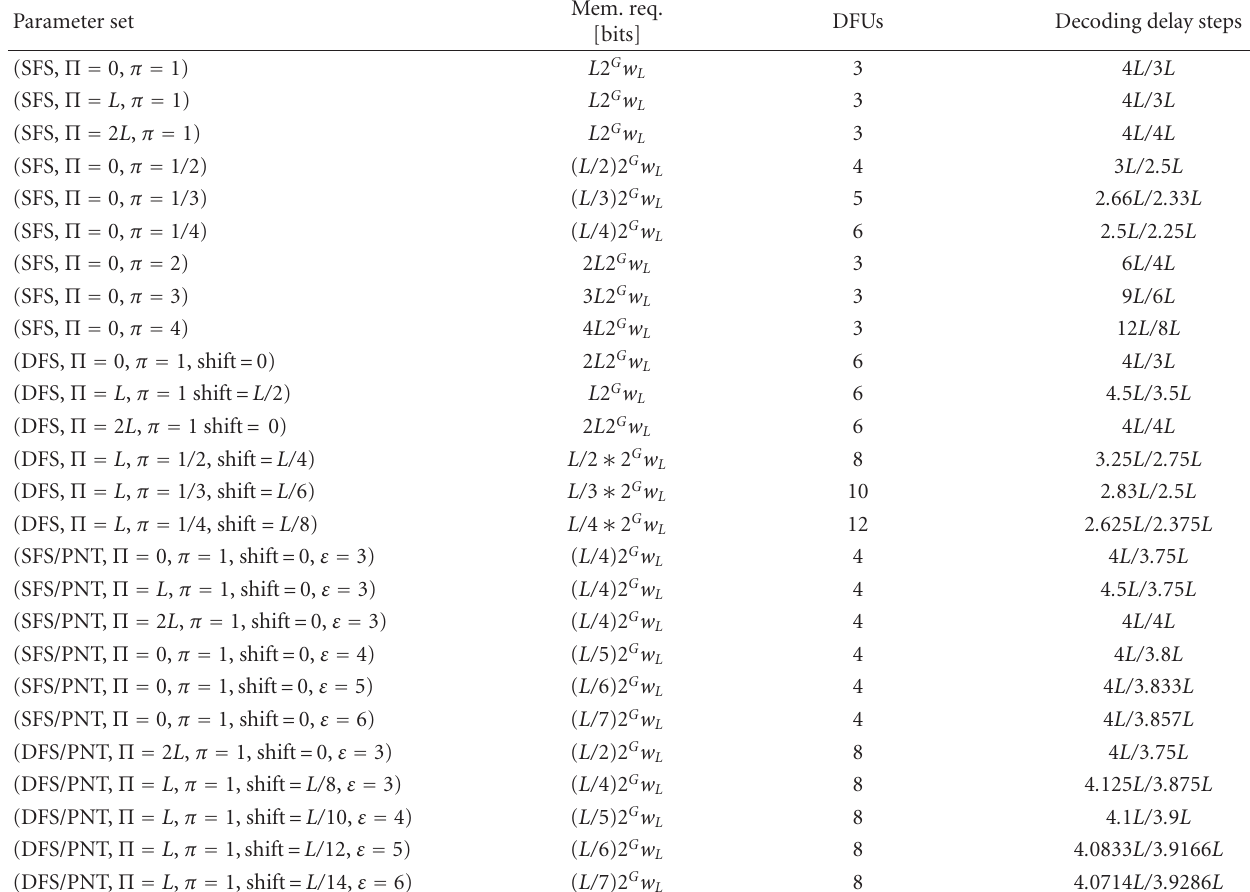
Table 2: Complexity and decoding delay of SWT-based log-MAP